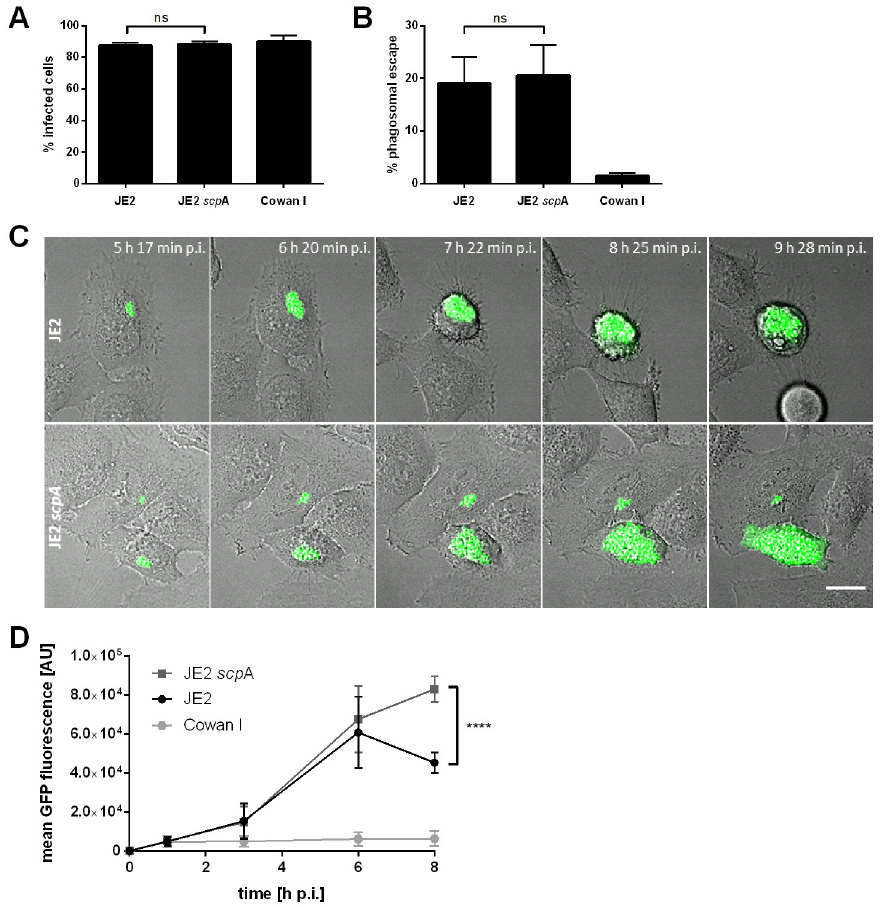
Fig 3. Staphopain A does not interfere with S . aureus invasion and phagosomal escape, but prevents excessive intracellular replication in the host cell cytosol. HeLa cells were infected with wild type bacteria (JE2), staphopain A mutant (JE2 scp A) or non-cytotoxic Cowan I expressing the fluorescent proteins GFP (A, C, D) or mRFP (B). (A) Invasion into host cells was assessed by measuring the percentage of infected, i.e. GFP-positive, cells at 1 h p.i. by flow cytometry. (B) Phagosomal escape was quantified in the marker cell line HeLa YFP-CWT 3 h p.i. by automated microscopy. (C) Live cell imaging was performed to study intracellular replication of wild type JE2 (upper panel) and staphopain A mutant (lower panel) by fluorescence microscopy (green: S . aureus , gray: BF, scale bar: 20 μ m). (D) The mean fluorescence of infected cells was determined at 1, 3, 6 and 8 h p.i. by flow cytometry to analyze intracellular replication. Statistical significance was determined by one-way ANOVA (A, B) or two-way ANOVA (D) ( ���� P < 0.0001).